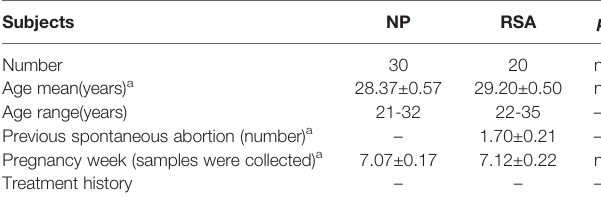
TABLE 1 | Demographic and obstetrical characteristics of enrolled